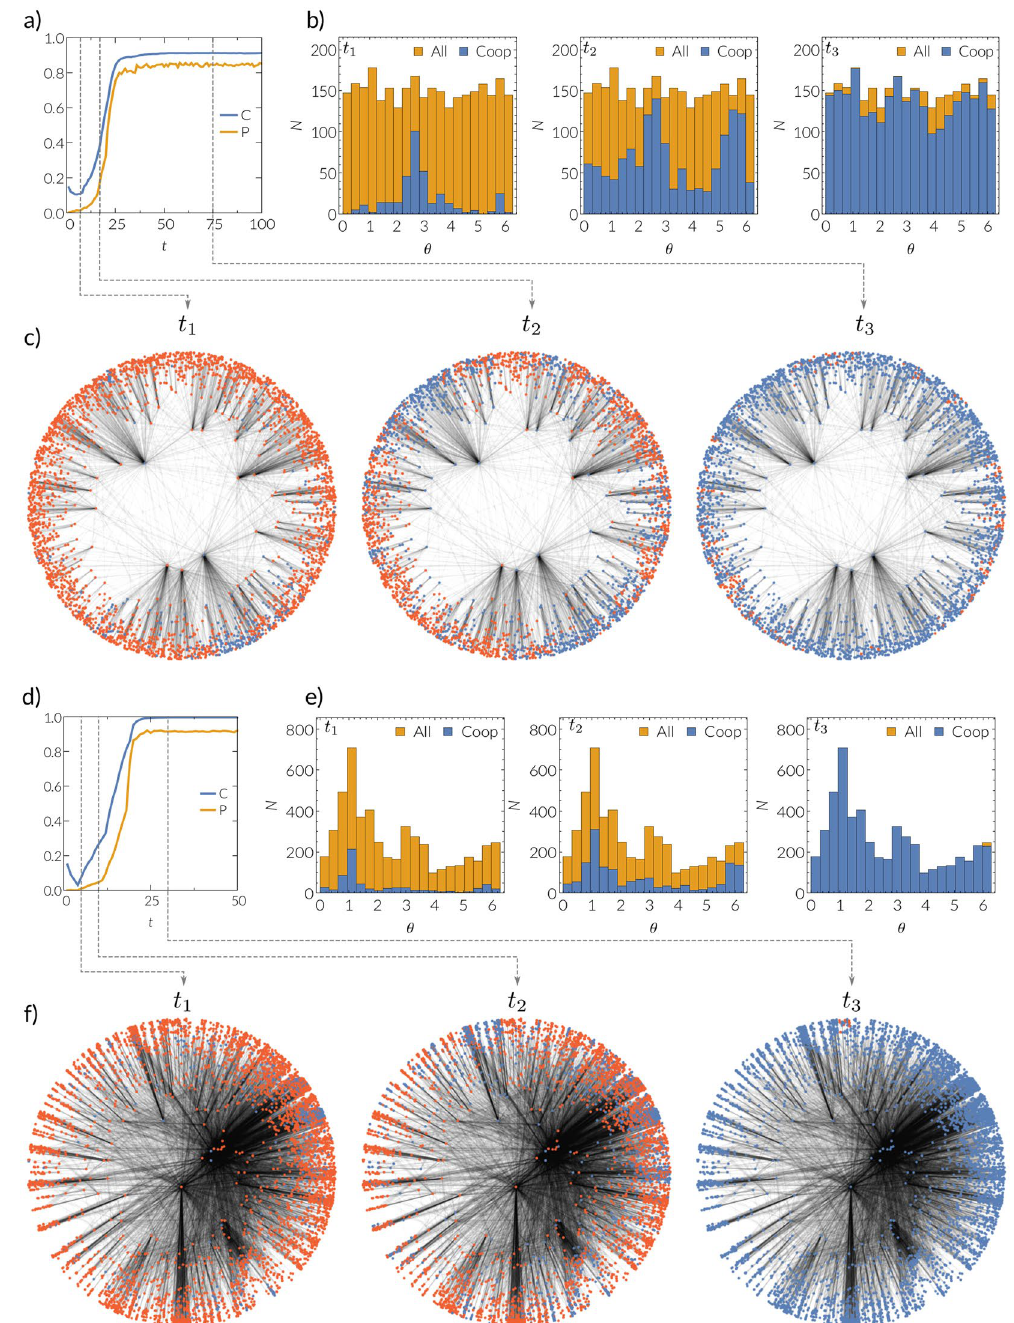
Figure 3. ( a ) Emergence of cooperation in a synthetic network for b = 25 and C 0 = 0.15 with N = 3000 nodes and a power law degree distribution with exponent γ = 2.5, temperature T = 0.4, and mean degree < k > ≈ 6. We show the evolution of the density of cooperators (blue line) and the success rate of navigation (yellow line). Time t represents the number of update phases the system has undergone. (b) Histograms for the same realization for the number of cooperators (blue) and total number of nodes (yellow) in respective bins of the angular coordinate θ . Time increases from left to right, t = (7, 17, 75). (c) Network and states of the nodes for times t = (7, 17, 75) for the same realization, see Supplementary Video 1. ( e,f ) Same as a–c , but for the IPv6 Internet network and for C 0 = 0.15 and b = 30. Times shown are t = (5, 10, 30), see Supplementary Video The role of hubs. Hubs, i.e. nodes with very high degree, play an important role in the navigation process. In particular, the navigation process follows a “zoom in - zoom out” pattern, where hubs—forming large-range connections in the metric space—facilitate the transmission of messages across the network 11 . Therefore, one